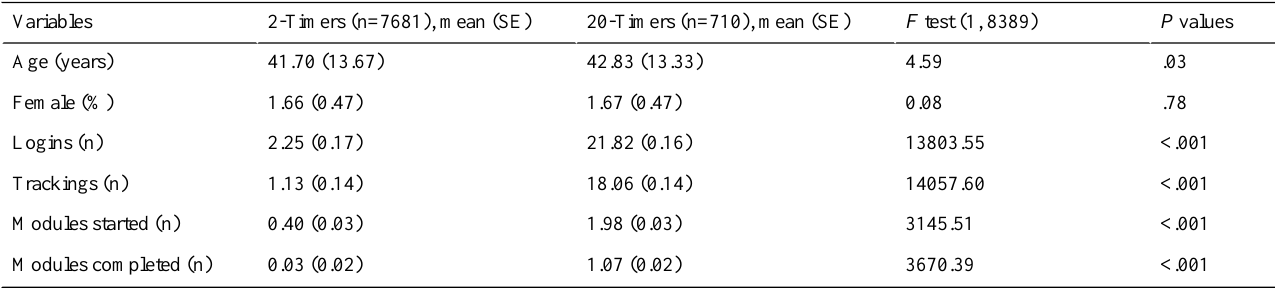
Table 3. Cluster analysis groupings of 8391 myCompass general public users usage behaviors and multivariate analysis of variance testing of the significant difference between